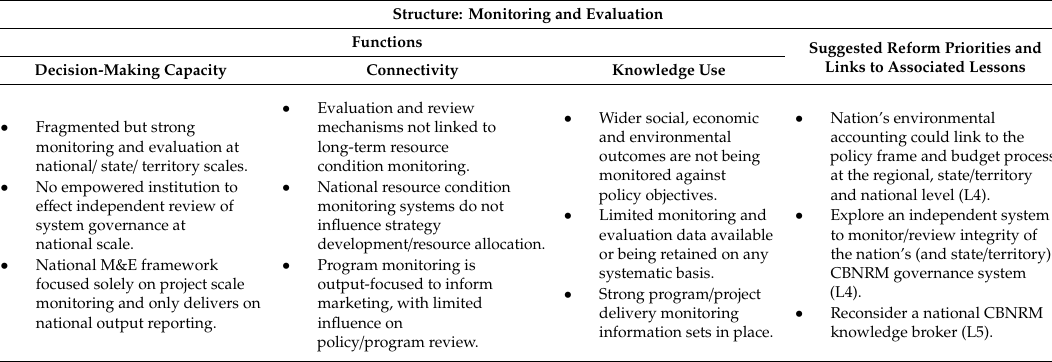
Table 6. A synthesis of findings regarding national aspects of monitoring and evaluation of Australia’s CBNRM governance